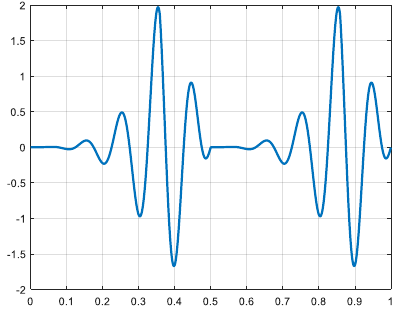
Figure 17. Current in one phase of the motor